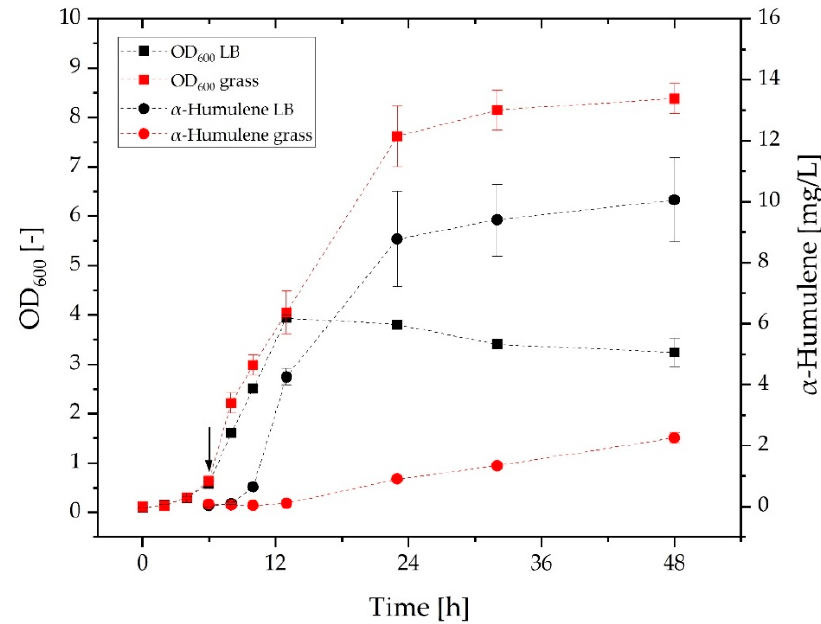
Figure 3. Growth curves of C. necator pKR-hum in grass medium and LB medium as well as the respective α -humulene concentration in the organic phase. The induction of α -humulene production after 6 h is indicated by the arrow ( n = 3, dashed line serves as a guide to the eye ).